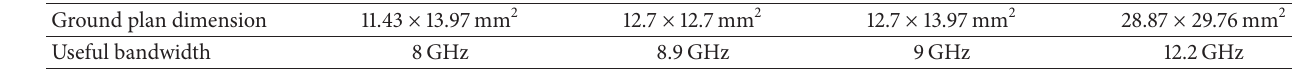
Figure 10: (a) Front view of fabricated antenna. (b) Bottom view of fabricated antenna. Table 2: Optimization of bandwidth using different ground plan dimensions.